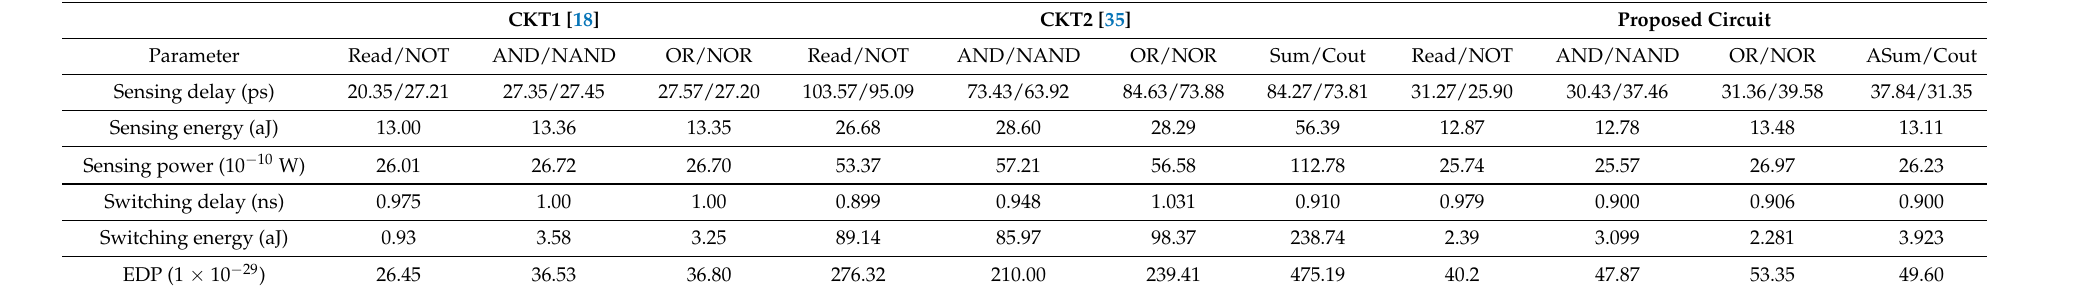
Table 3. Performance metrics of the multifunctional circuit and its counterpart circuits (T = 300 K, TMR = 208, RL = 26.5 K, RH = 81.7